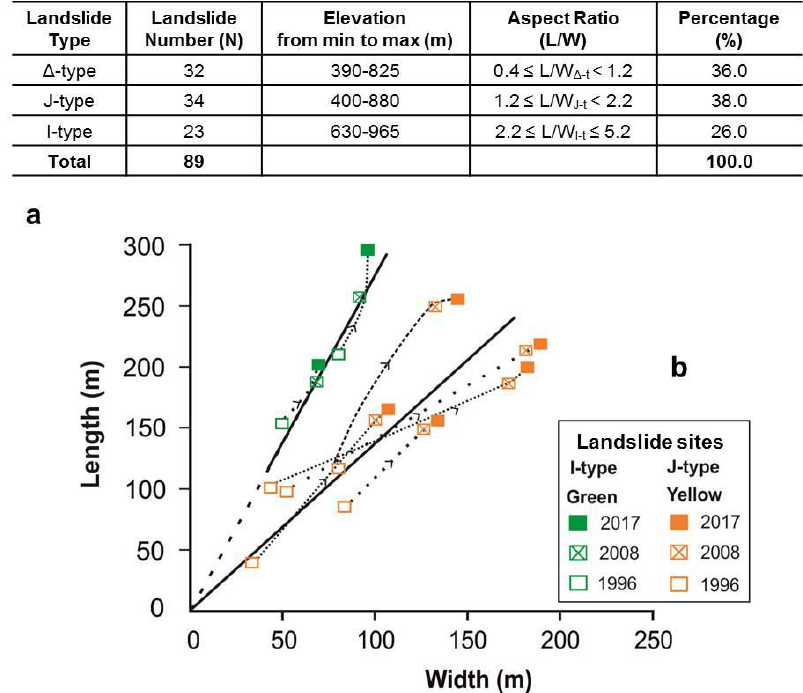
Figure 7. ( a ) Table of aspect ratios of landslide types at Skolis Mtn; ( b ) Plot showing the temporal increase of the length or the width of the I- and J-type slides at Santomerion village.